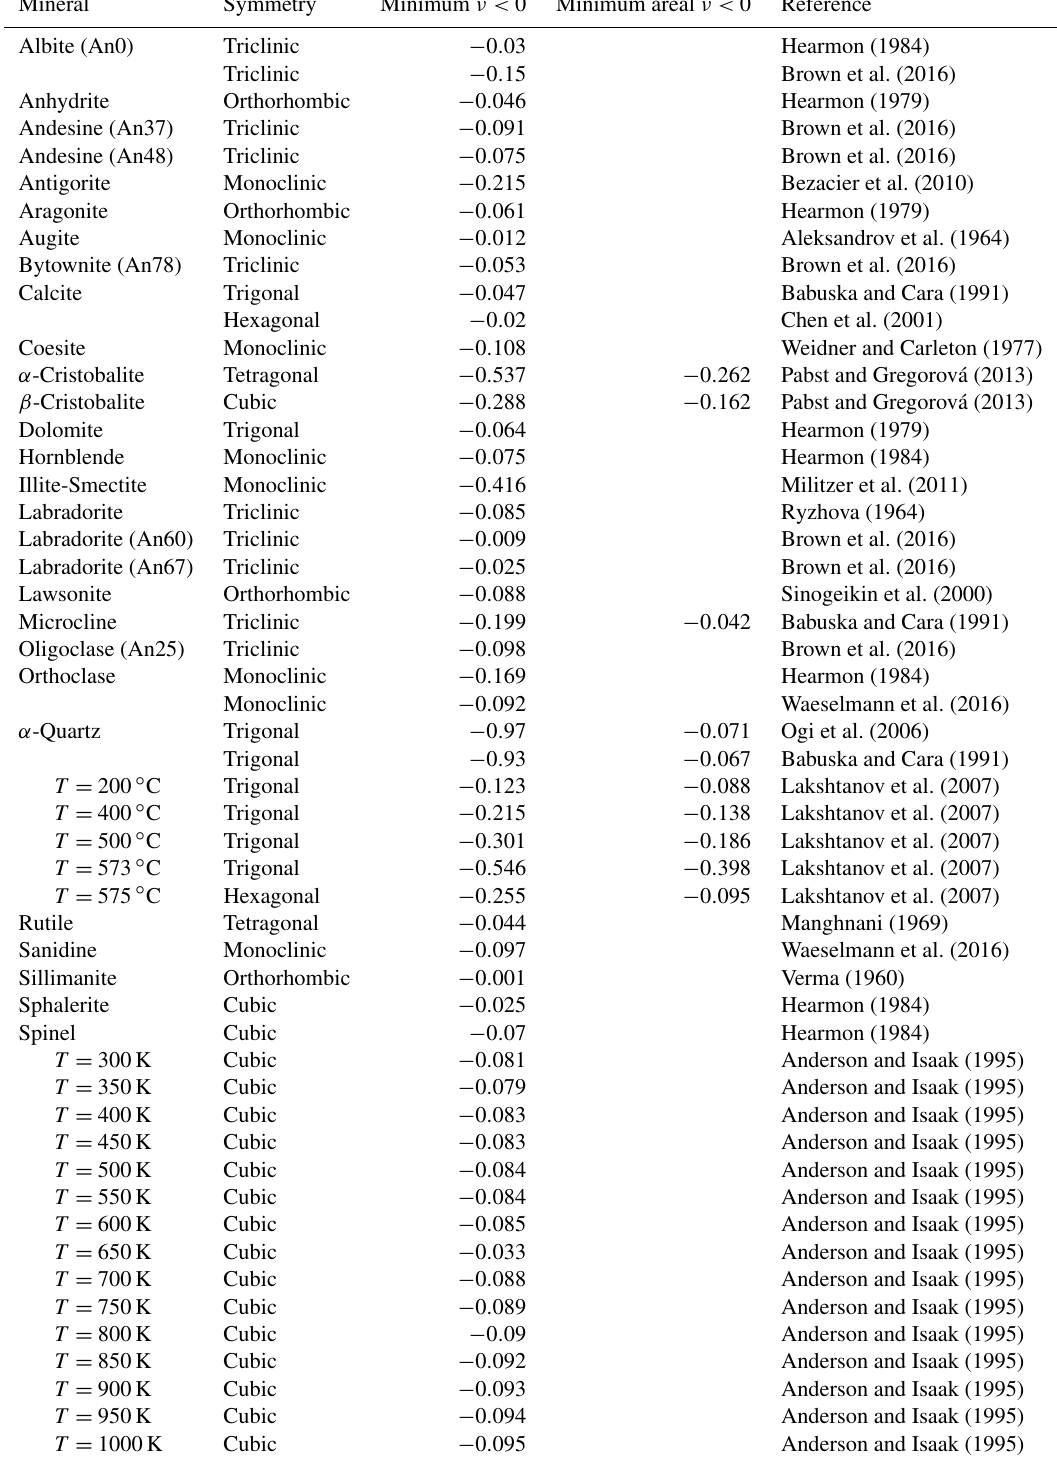
Table 2. List of rock-forming minerals showing auxetic behaviour (Poisson’s ratio < 0) in at least one direction. Also shown are those minerals with directions that have negative areal Poisson’s ratio (Guo and Wheeler, 2006). The “Reference” column shows the source of the elasticity data for each mineral used in the calculation. The auxetic directions were found by calculating Poisson’s ratio for every possible direction ( α , β , θ in the Turley and Sines reference frame shown in Fig. 1) using an angular increment of 1 ◦ in each